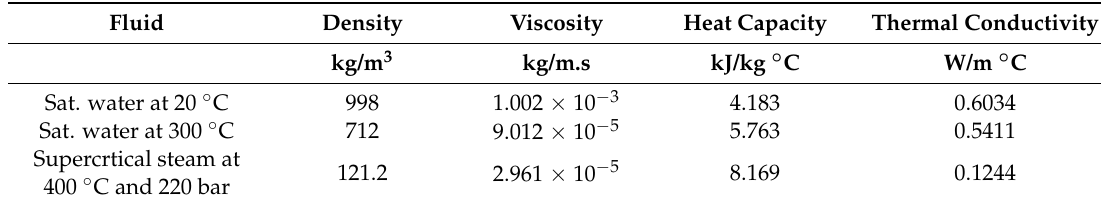
Table 4. Thermodynamic properties of water, imported from HYSYS to